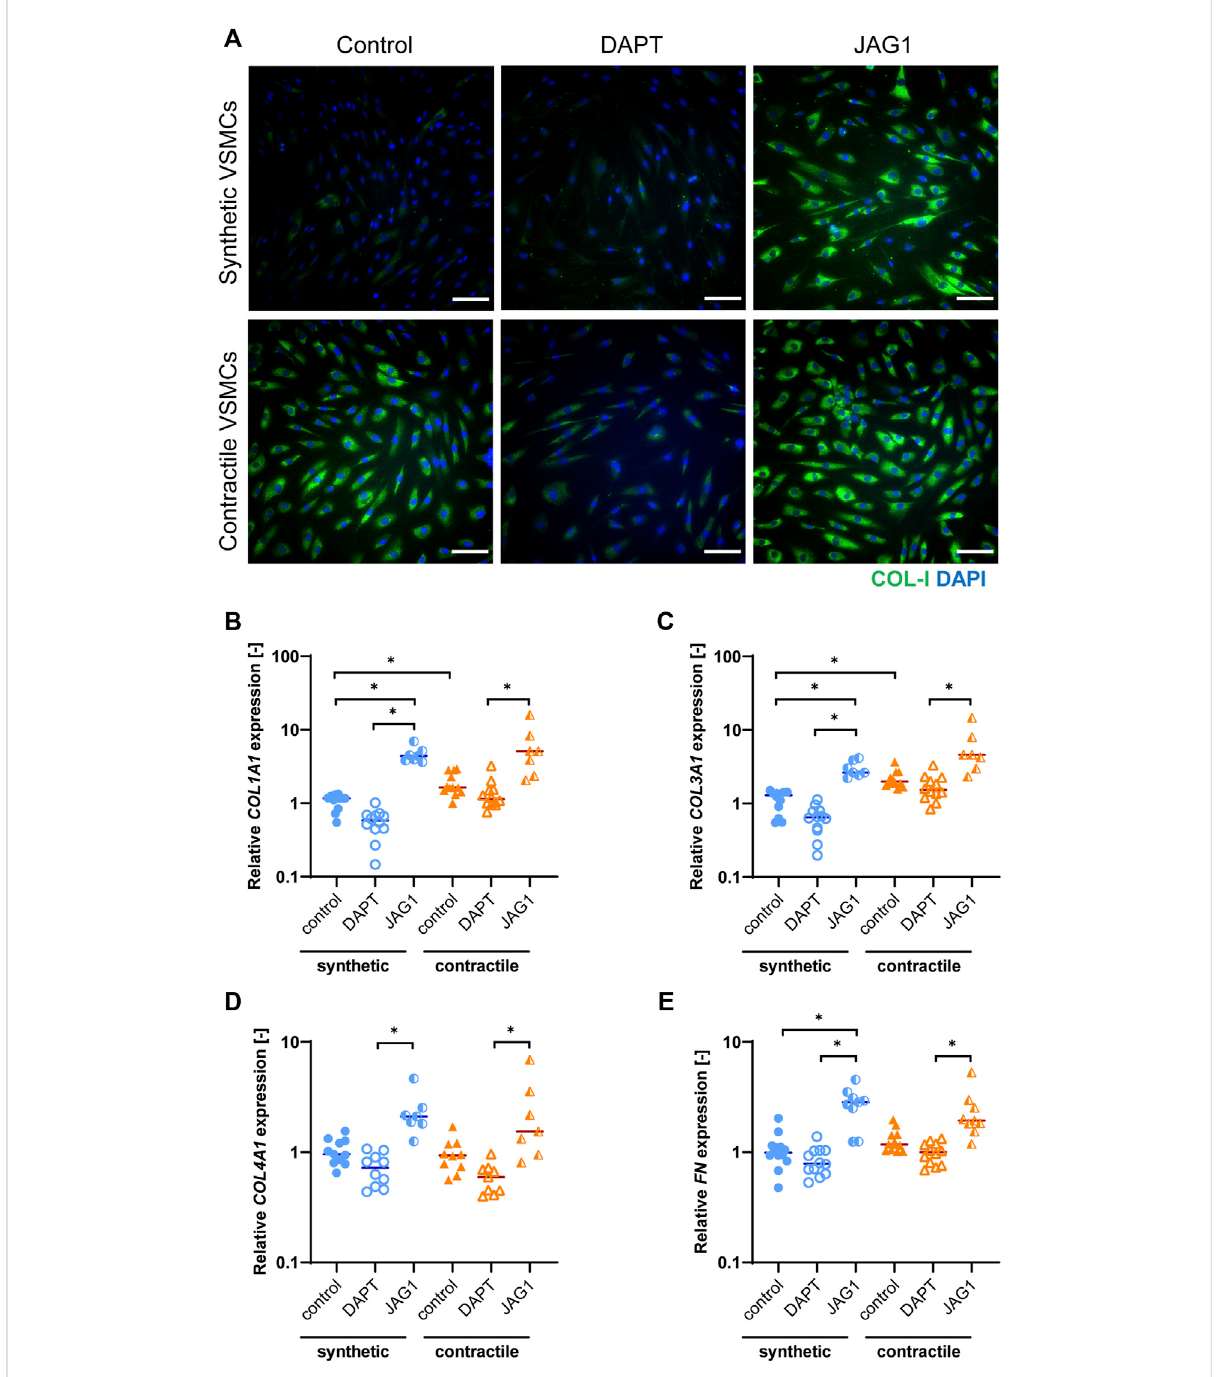
FIGURE 4 ECM production in synthetic and contractile VSMCs, and the impact of Notch signal inhibition and activation on ECM production. (A) Representative IF images of collagen I in green and nuclei in blue for control, DAPT-treated and JAG1-induced synthetic and contractile VSMCs (scale bar: 100 μ m). Gene expression of ECM components (B) COL1A1 , (C) COL3A1 , (D) COL4A1 , (E) FN , normalized to the synthetic control condition (* p < 0.05